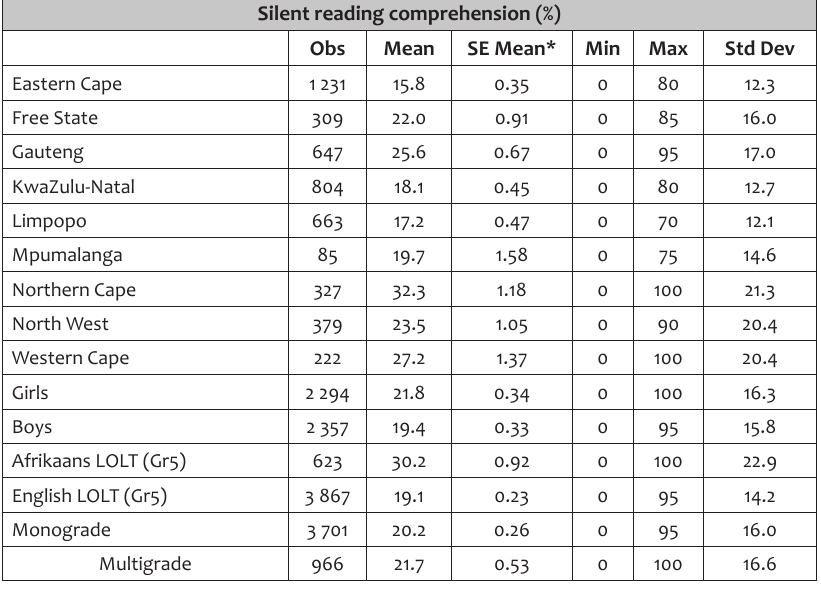
Table 7: Descriptive statistics for key variables and sub-groups Silent reading comprehension (%) Obs Mean SE Mean* Min Max Std